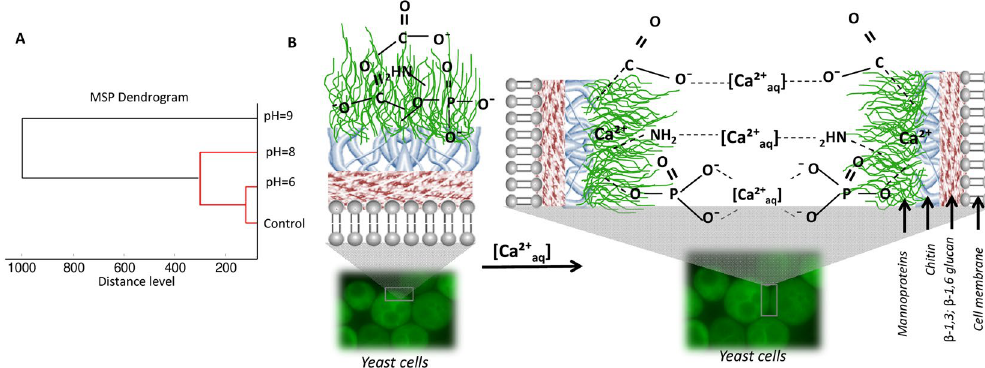
Figure 5. MSP dendrogram for MALDI-TOF MS spectra of S . cerevisiae modified with 5 mM Ca(NO 3 ) 2 solution at pH 6, 8, 9 and native S . cerevisiae (non-modified) ( A ). Model of yeast cell wall controlled clumping mechanism ( B